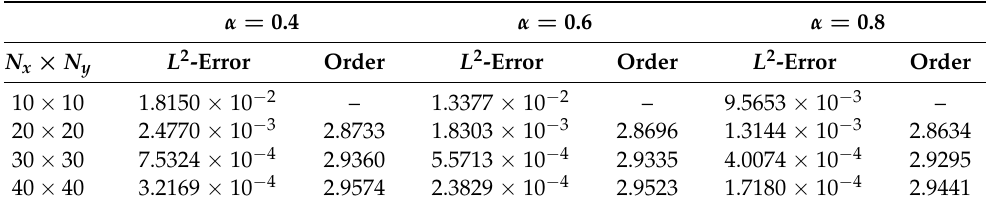
Table 4. The L 2 -norm errors and spatial convergence orders for Example 1 using scheme (18), M = 1000, T = 1/4, r = ( 2 − α ) / α , k = 2.